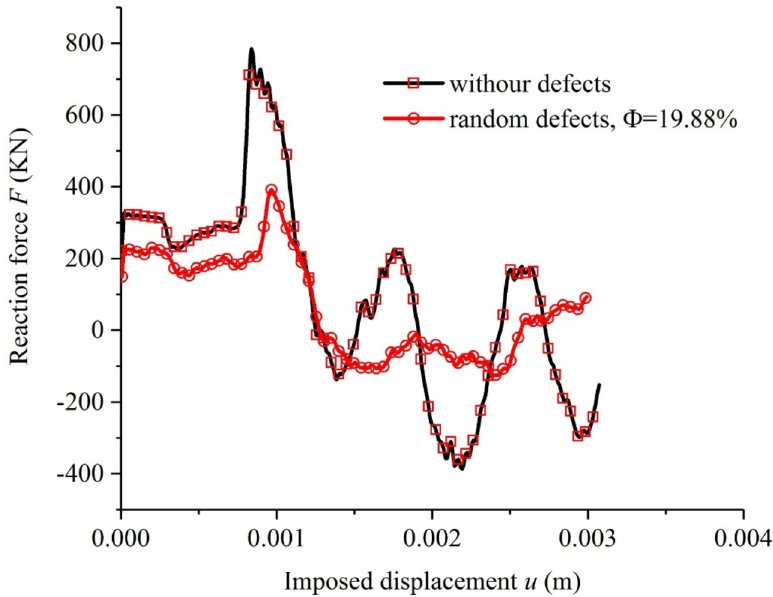
Figure 11. Curves of the reaction force versus imposed displacement.